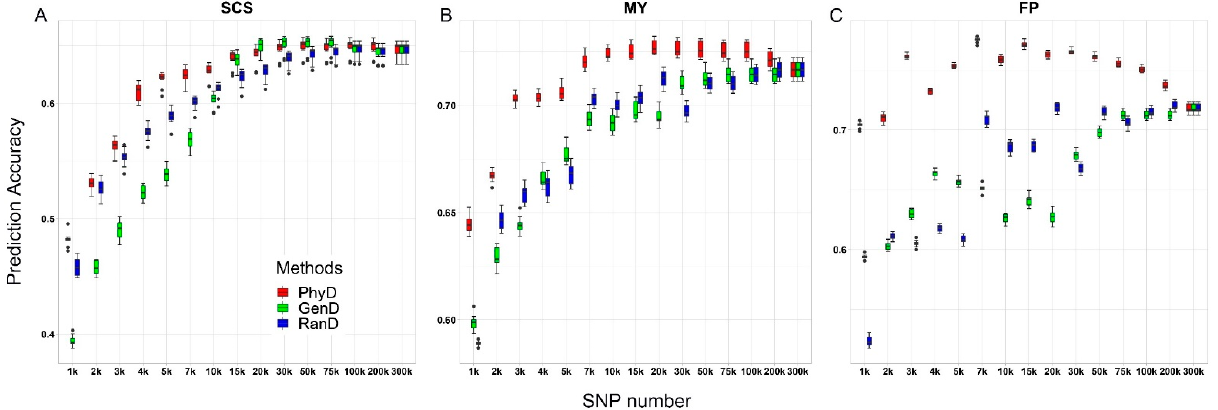
Figure 3. Box plots of genomic prediction accuracy against SNP numbers for three dairy cattle traits. The genomic prediction accuracy of panels with different SNP numbers constructed by PhyD, GenD or RanD for somatic cell score (SCS), milk yield (MY) and milk fat percentage (FP) are shown in ( A – C ) respectively.